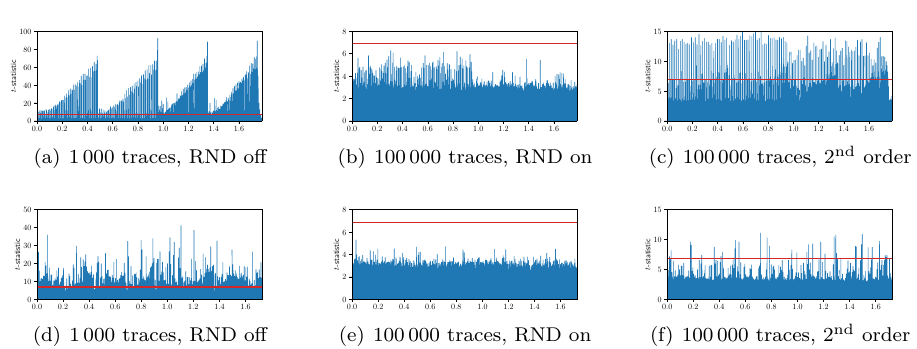
Figure 6: Results of TVLA assessment: the top row shows decompressed comparison for (a) 1 st order without randomness, (b) 1 st order with randomness, and (c) 2 nd order with randomness, while the bottom row shows 1-bit compression for (d) 1 st order without randomness, (e) 1 st order with randomness, and (f) 2 nd order with randomness. The x axis represents sample point index × 10 6